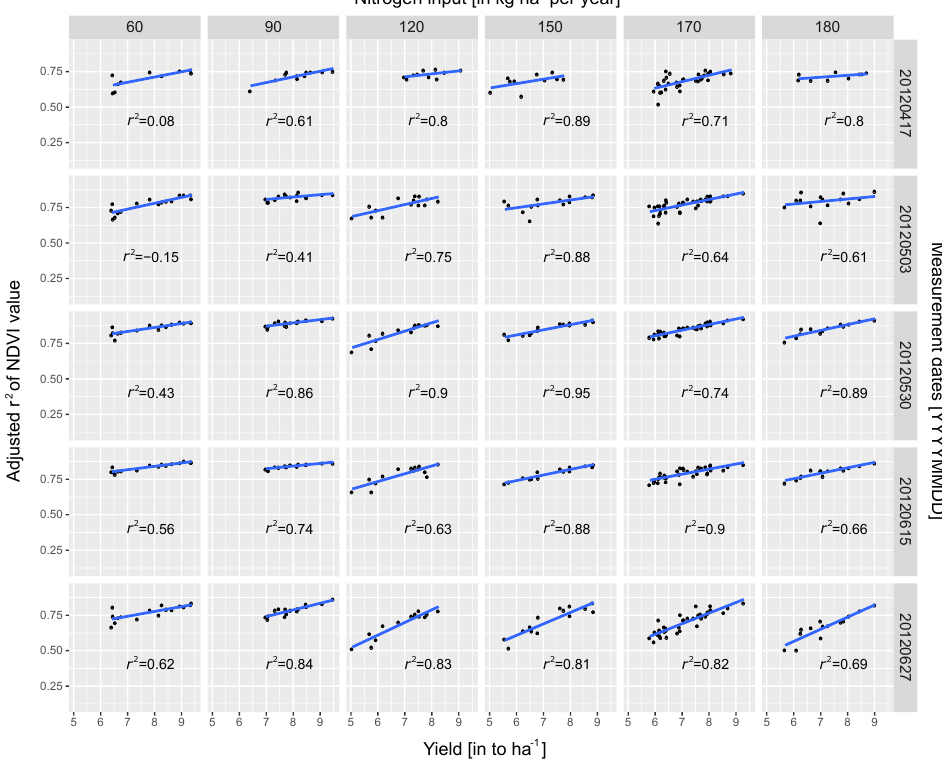
Figure 4. Adjusted r 2 values for normalized difference vegetation index (NDVI) of measurement period 2012 in wheat ( Triticum aestivum L.) field “Lammwirt”, gathered with FieldSpec HandHeld spectrometer, class-divided by measurement dates and nitrogen input. Adj. r 2 shows the percentage of variation explained by the independent variable (NDVI) that affect the dependent variable